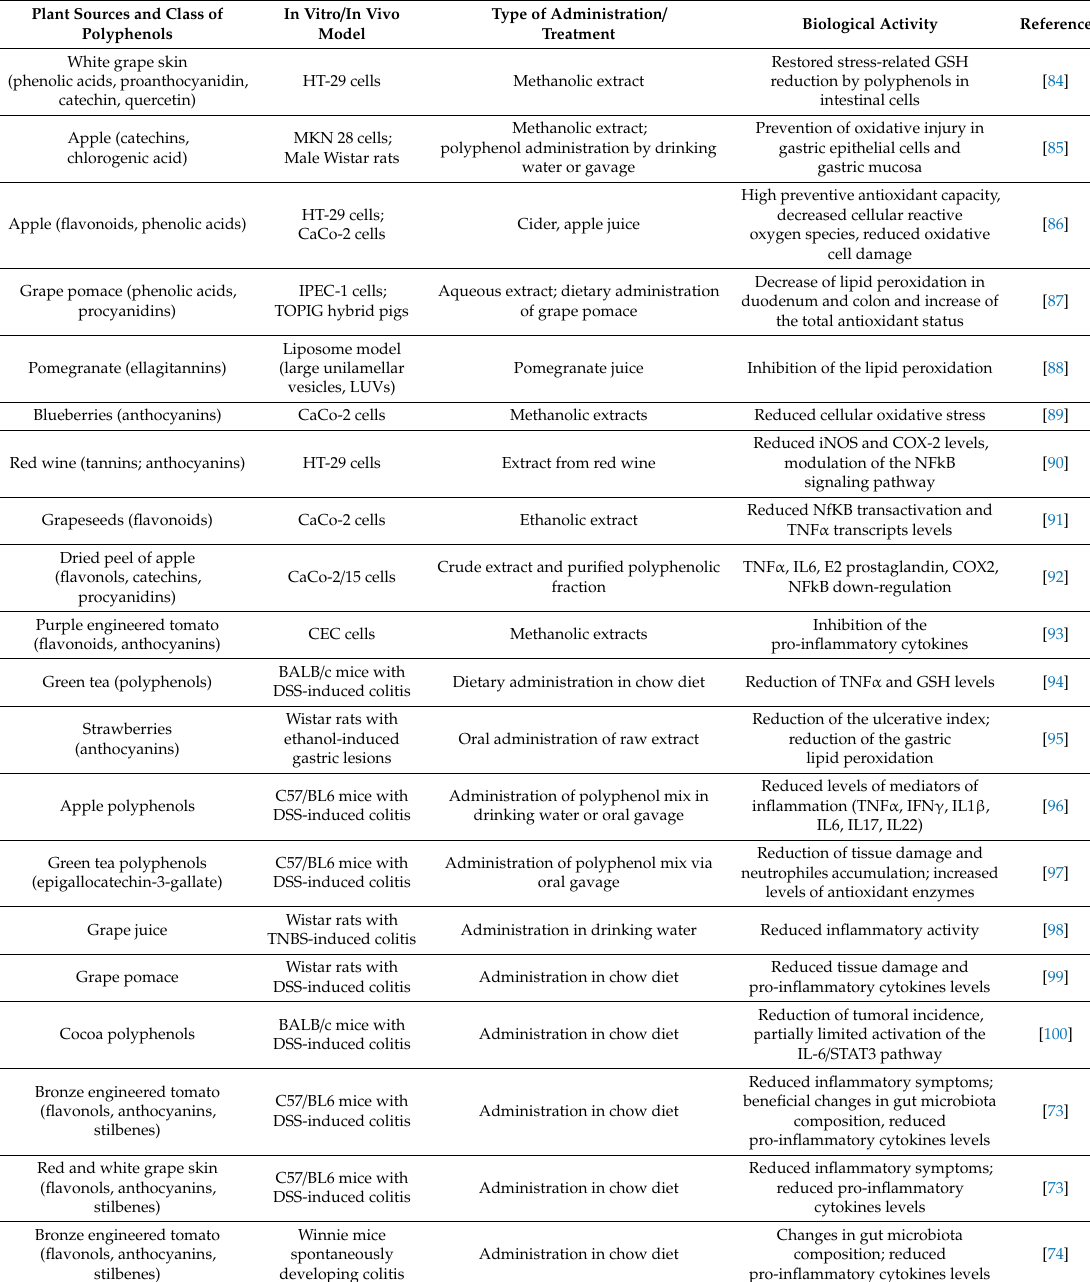
Table 2. Examples of in vitro and in vivo studies used to evaluate polyphenols antioxidant and anti-inflammatory activities at intestinal